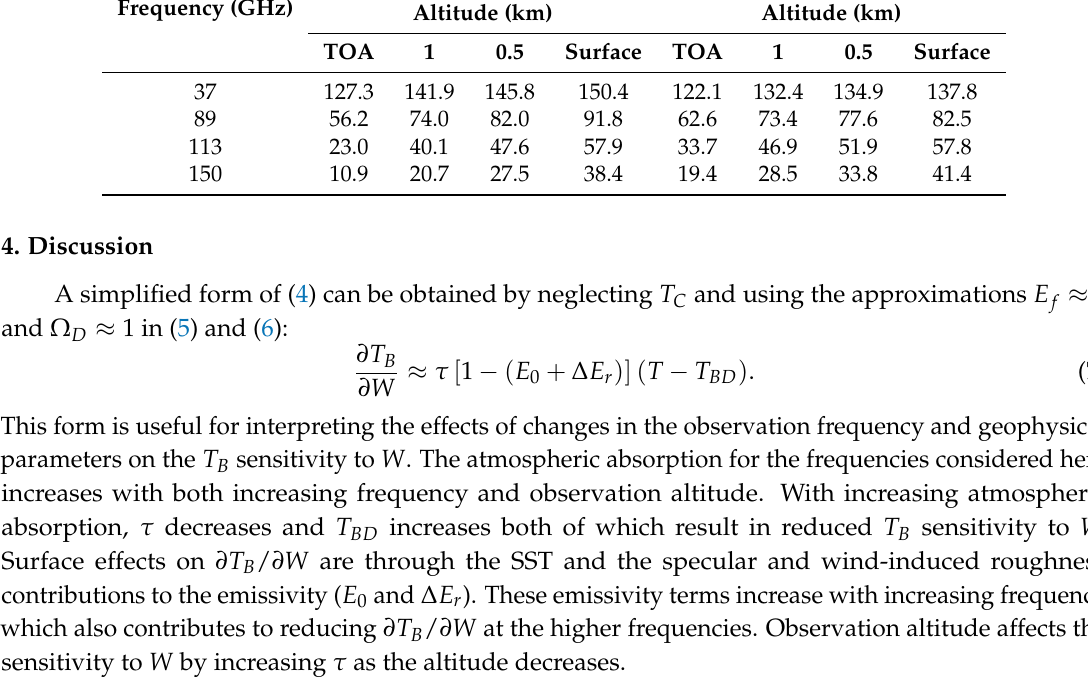
Table 1. Median ∂ T B / ∂ W for different frequencies, altitudes and two EIAs and H polarization. 53 ◦ EIA 0 ◦ (nadir) Frequency (GHz) Altitude (km) Altitude (km) TOA